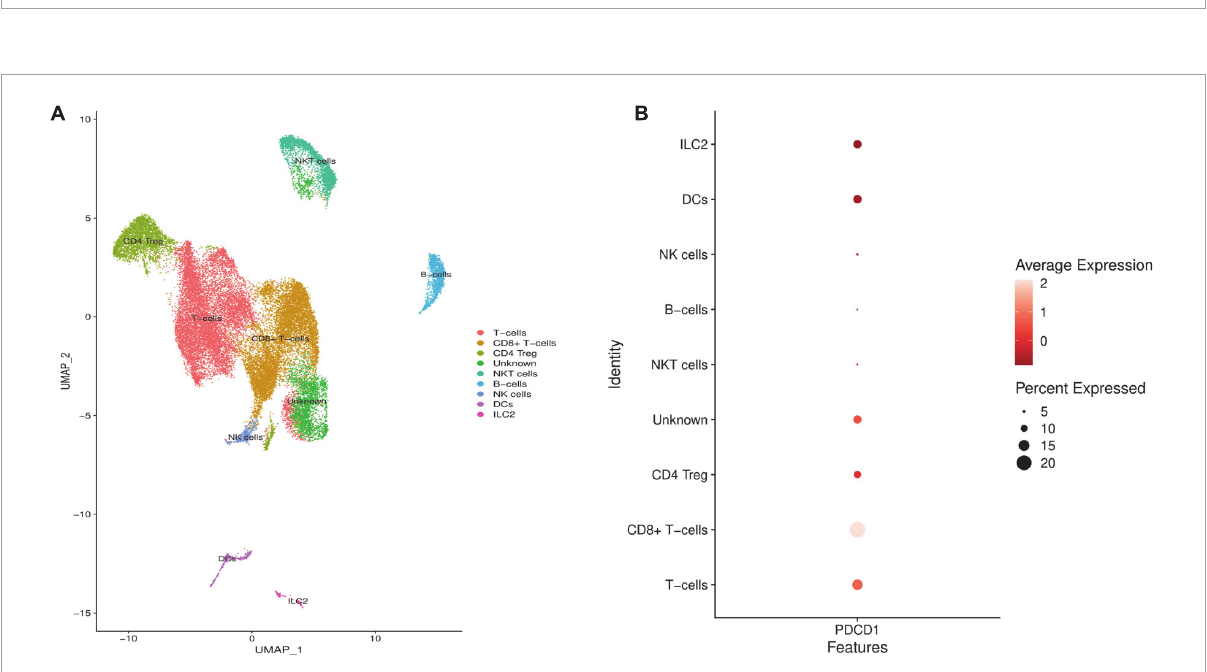
FIGURE3 The prognostic values of hsa-miR-200a-3p and hsa-let-7c-5p, as programmed death-ligand 1 (PD-L1)-inhibiting miRs, based on TCGA-LUAD and TCGA-LUSC databases. (A) High expression of hsa-miR-200a-3p is associated with enhanced disease-specific survival of LUAD patients. (B) High expression of hsa-let-7c-5p is associated with improved disease-specific survival of patients with lung squamous cell carcinoma